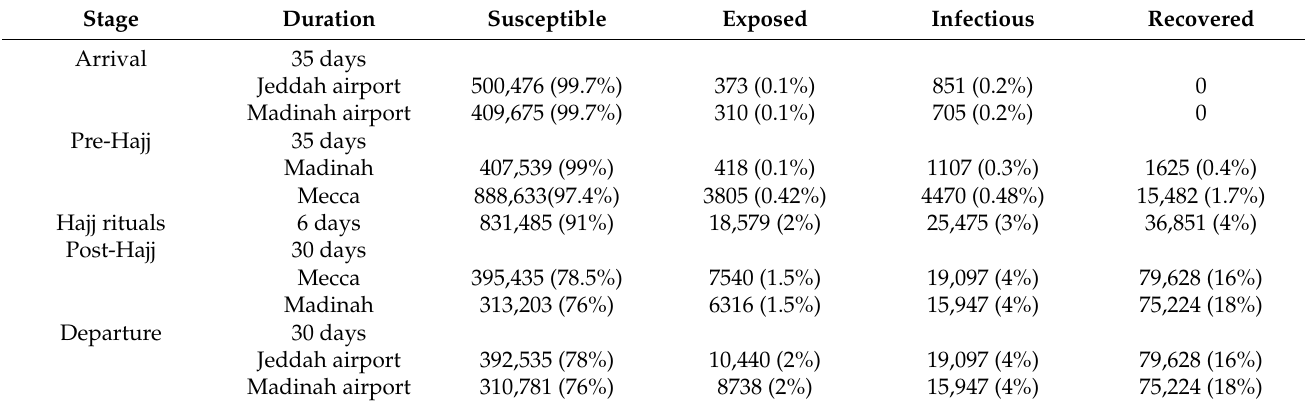
Table 3. Summary of the results of disease spread simulations in the whole population of international pilgrims at the end of the main stages of Hajj: the arrival stage, the actual Hajj rituals, and the departure stage.